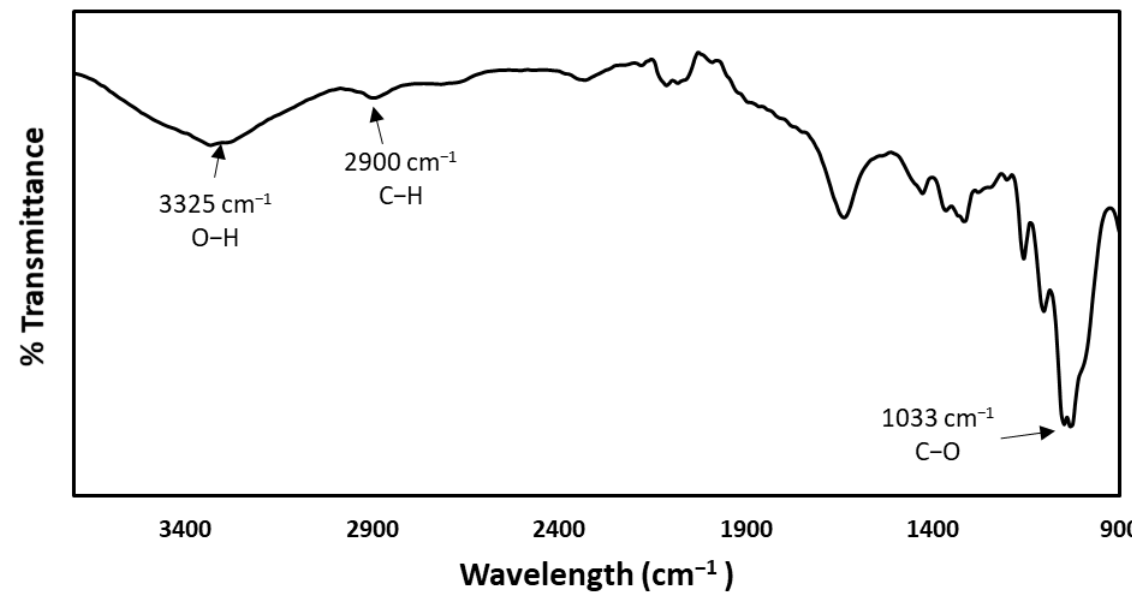
Figure 4. FTIR spectra of BCD − AuNPs.